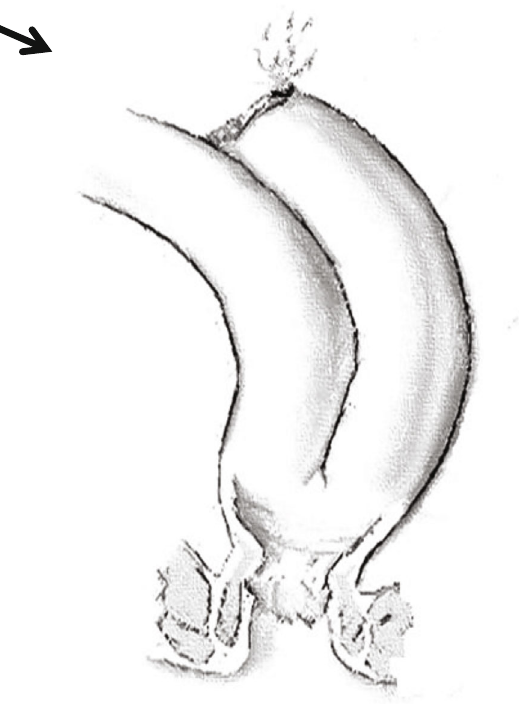
Figure 1: Perforation at the blind end of ileal